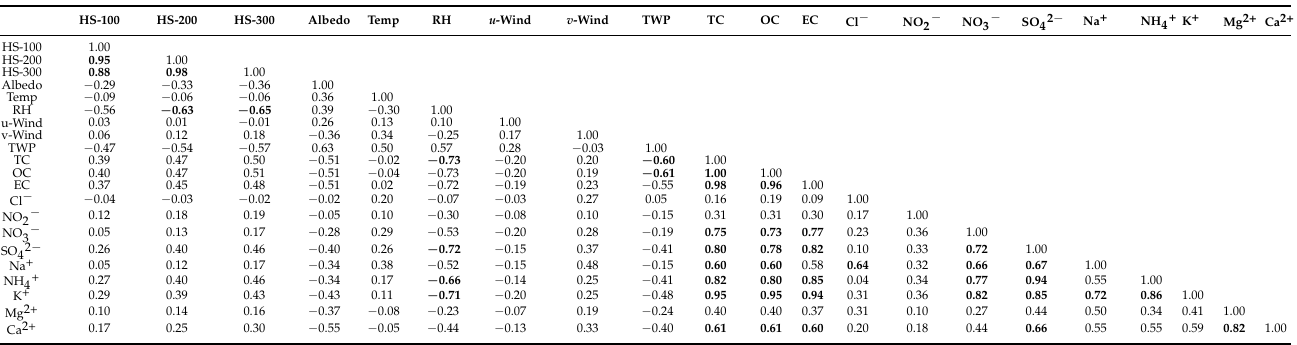
Table 4. Pearson correlation coefficients of meteorological parameters and chemical species in PM 2.5 collected at COS, BOS, and POS. Any values that higher than 0.5 and lower than − 0.5 will be highlighted as